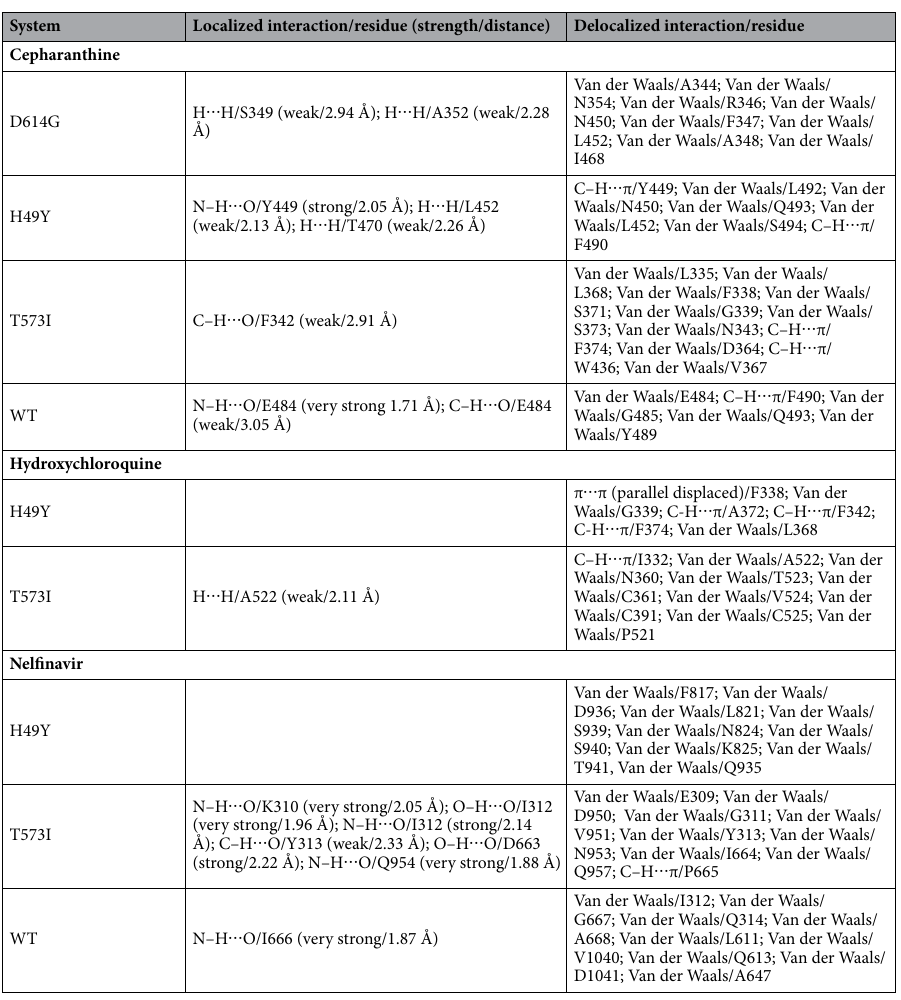
Table 2. The localized and delocalized interactions found for each protein–ligand complex within the NCI